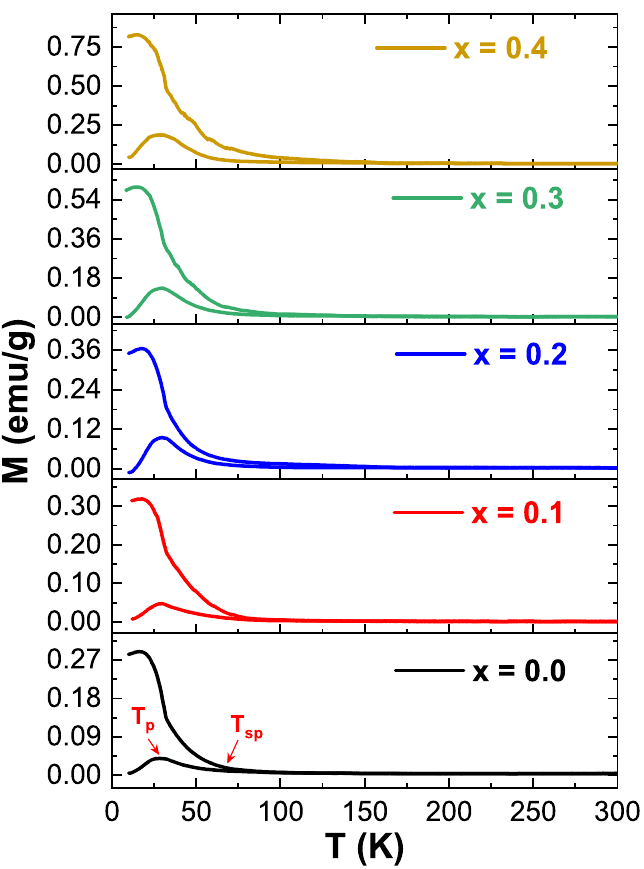
Figure 8. M–T graph (temperature dependence of magnetization) of V x -MnCo (x ≤ 0.4) MCs measured under FC and ZFC conditions and a dc-magnetic field of 100